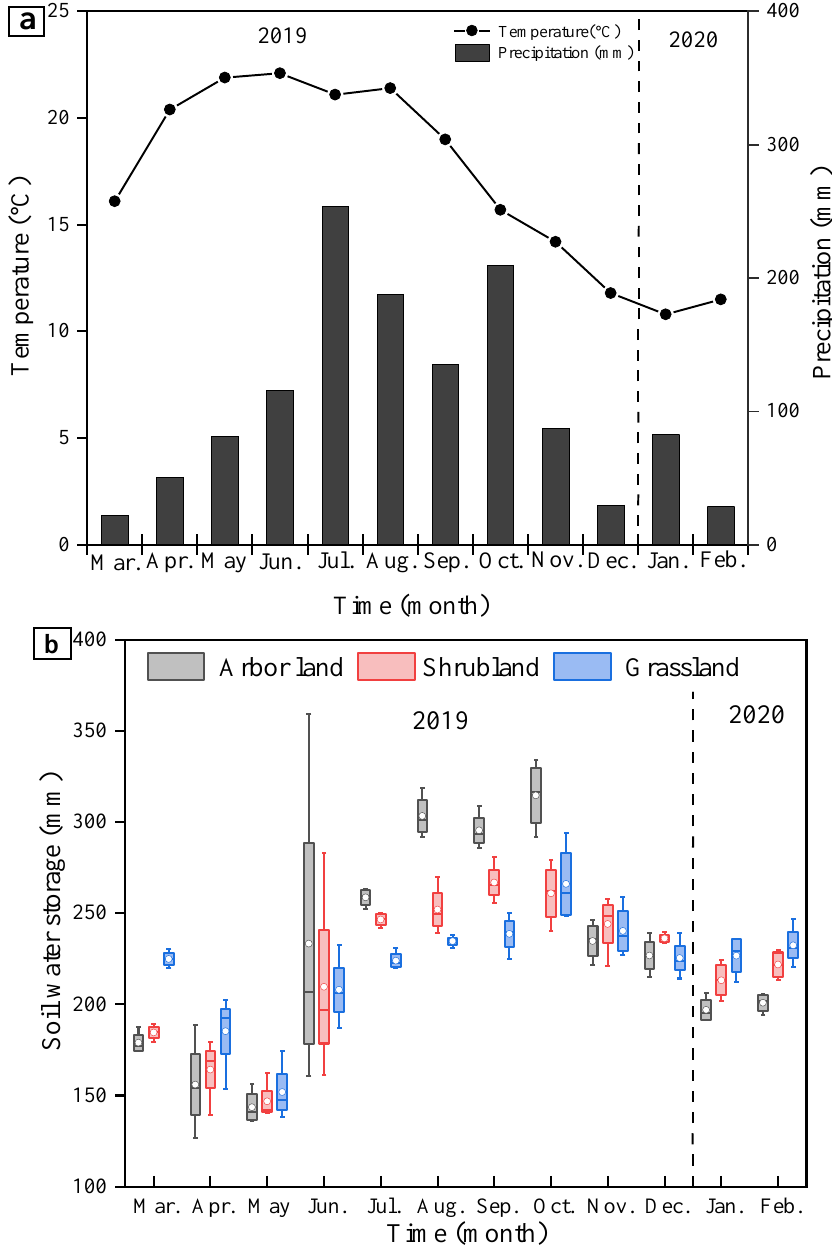
Figure 2. Monthly variations of air temperature and precipitation ( a ) and soil water storage ( b ). The dry season (March to April and November to February of the following year) precipitation was 302.0 mm, accounting for only 23.5% of the annual precipitation. Moreover, the dry season comprised a total of 55 precipitation days, accounting for 33.1% of the total annual precipitation days. Temperature was the lowest in January, with a monthly average value of 10.8 °C. The soil moisture content of the arbor land showed large fluctuations, ranging between 126.80 and 246.00 mm (average